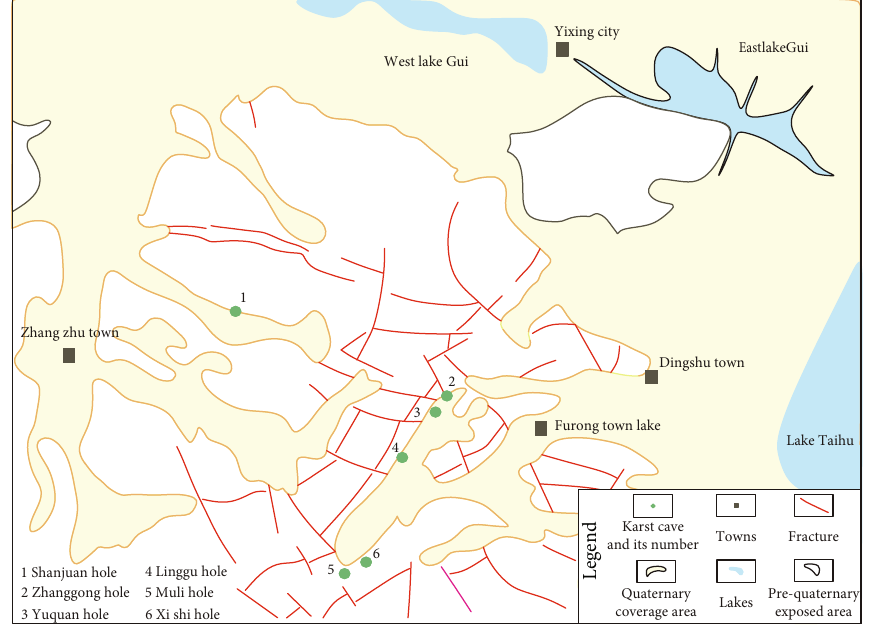
Figure 8: Distribution diagram of large karst caves in Yixing,